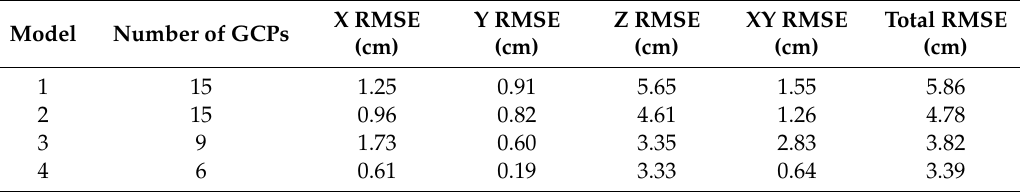
Table 2. Root-mean-square error (RMSE) between the coordinates of the GPS control points and their calculated position in the Metashape